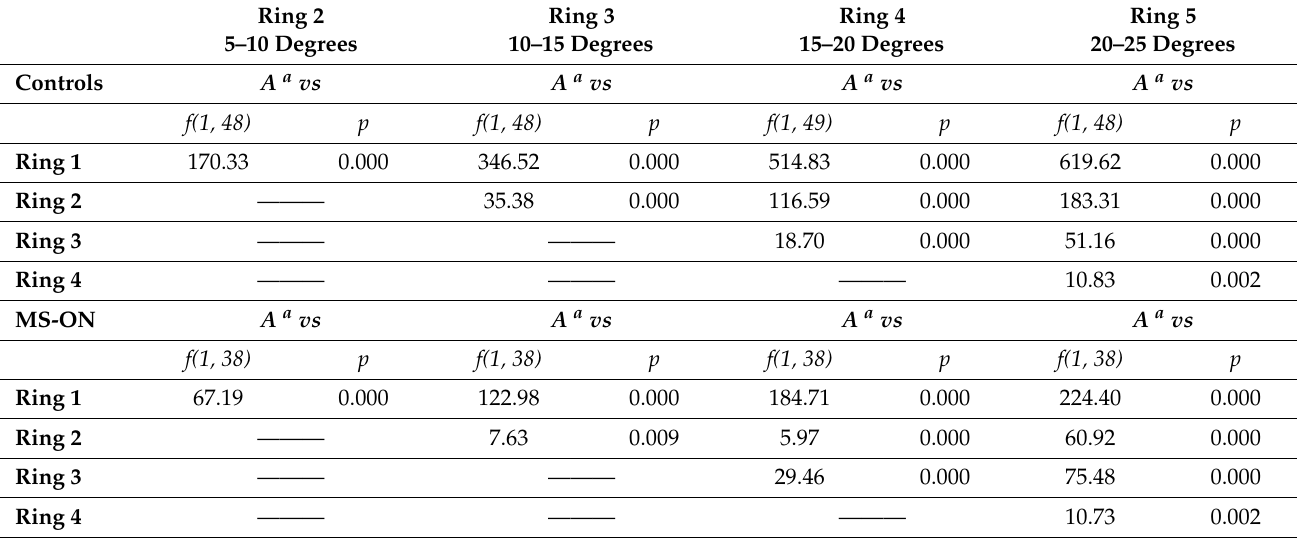
Table 2. Statistical differences between the multifocal photopic negative response (mfPhNR) ring analysis mean data obtained in different localized retinal areas in control eyes and in multiple sclerosis patients with optic neuritis